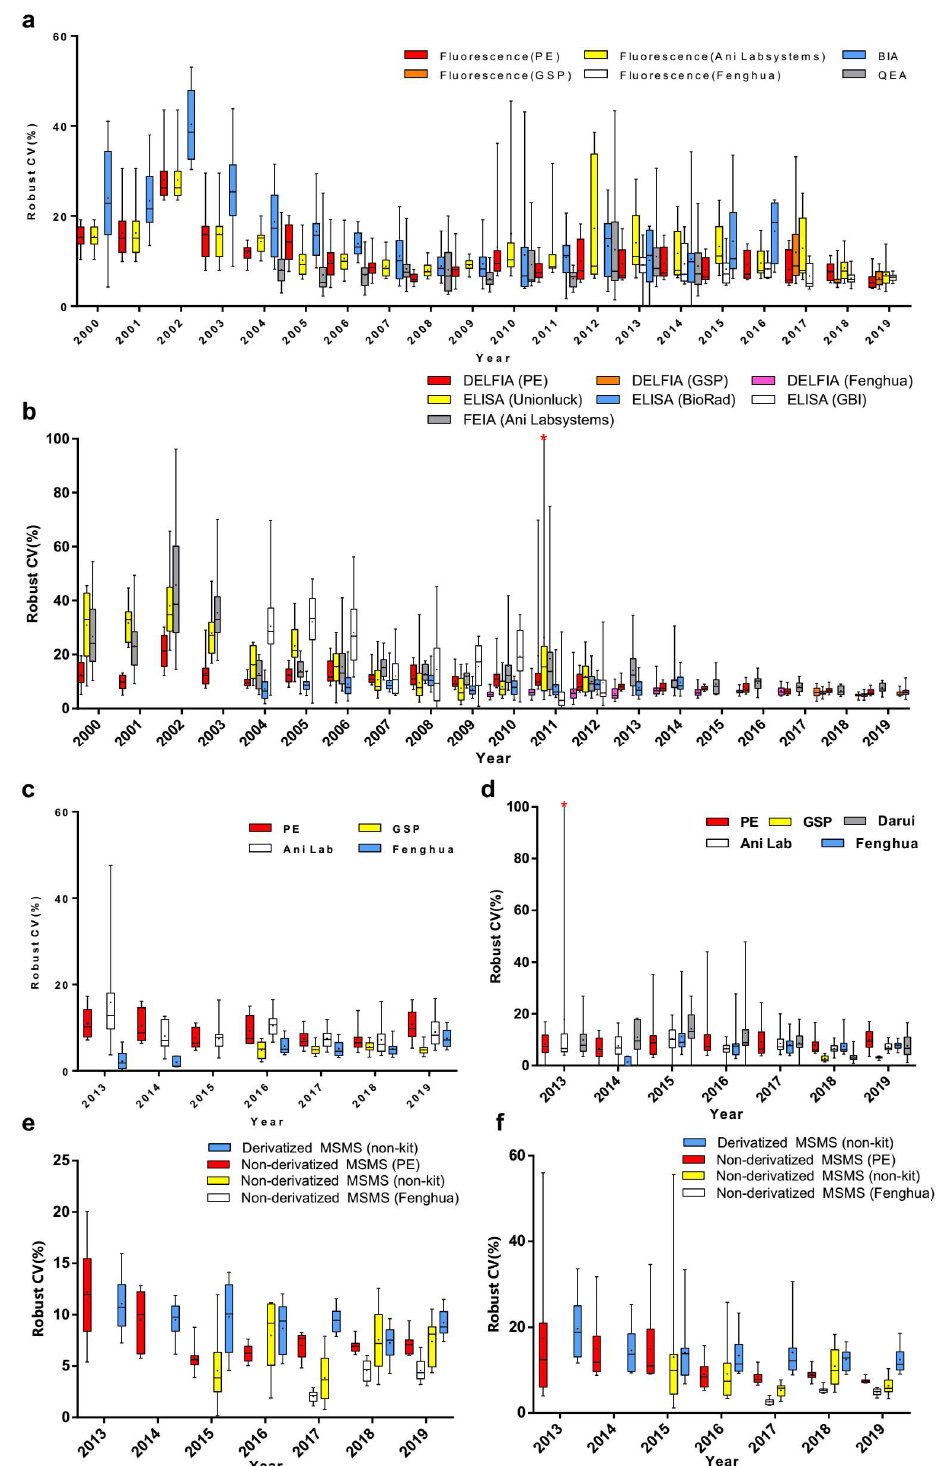
Figure 3. Annual variation of robust CV grouped by detection system of ( a ) Phe, ( b ) TSH, ( c ) G6PD, ( d ) 17OHP, ( e ) Phe and ( f ) free carnitine. Box-and-whiskers plots represent the median and interquartile range with whiskers ranging between the min and max; + indicates the mean of robust CV. * out-of-range value. n = 10 or 15 (n equals to the number of distributed DBS per year).